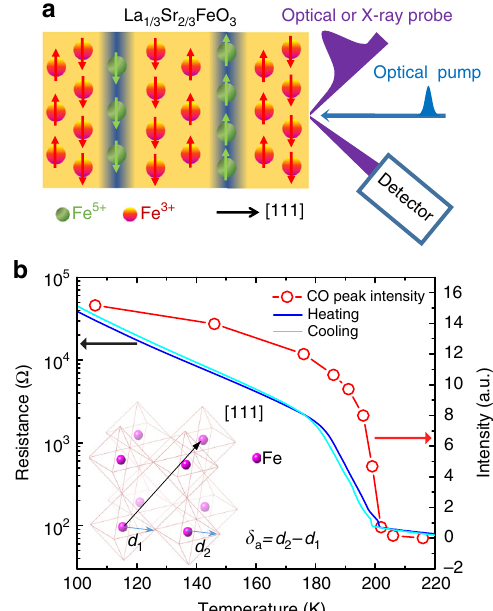
Fig. 1 Experimental setup and static sample characterization. a Schematic drawing of the LSFO charge and AFM ordering and the time-resolved optical and X-ray diffraction experiments. Below T c , Fe 3 + , and Fe 5 + ions order to form a periodic charge density distribution along the pseudo cubic [111] direction. Upon above-band-gap optical excitation, the transient optical re fl ectivity and the time-resolved X-ray diffraction from CO 4 superlattice and 222 lattice were measured. b The temperature-dependent CO diffraction intensity (red circle) and the resistance (blue for heating and cyan for cooling) of the sample. The inset shows oxygen octahedra with the differentially averaged Fe – O length δ a = d 2 -d